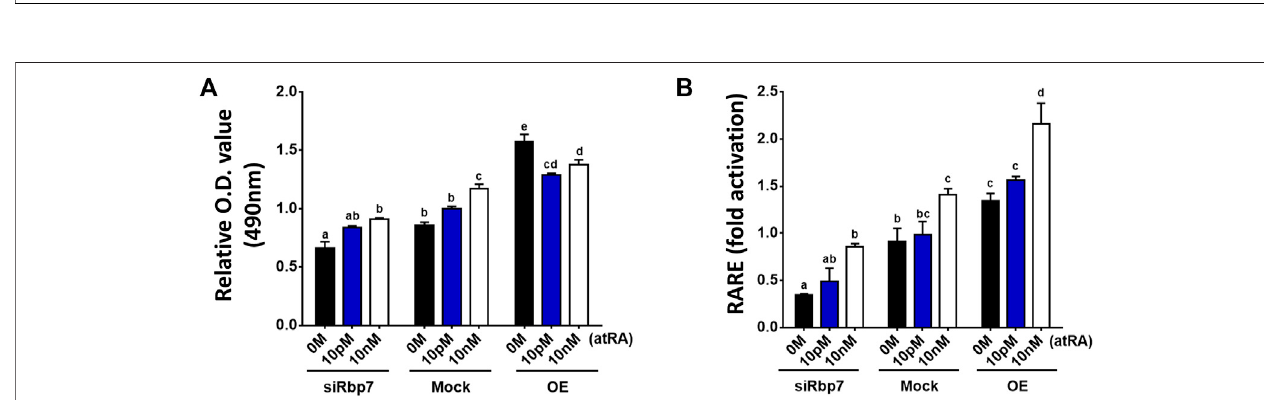
FIGURE 7 | RA addition rescues the effect of Rbp7 knock-down in adipocytes. (A) O.D. values of lipid droplets-associated Oil Red O. all- trans retinoic acid (atRA) treated siRbp7, Mock, and OE groups were stained with Oil Red O on day 8 of differentiation and analyzed the O.D. values by spectrophotometer. atRA was supplied dose dependently (0 M – 10 nM)during theentire period of thepreadipocytedifferentiation. (B) RARE luciferase activity on 3T3-L1cells. Rbp7knock-down (siRbp7) and overexpression (OE) was induced by siRbp7 transfection and treatment of Rpb7 viral supernatants 2 days before atRA supplement into adipocyte differentiation medium dose dependently (0 M – 10 nM) for 48 h. The value was normalized by activity levels of control (Mock 0 M), which did not induce Rbp7 knock-down/ overexpression and cultured without atRA. Signi fi cant differences were analyzed by the control (Mock 0 M) in Figures 6A,B . One-way ANOVA followed by Tukey ’ s multiple comparisons test was used and the bars indicate means ± S.E.M. Statistically signi fi cant differences are marked by the letters ( p < 0.05).